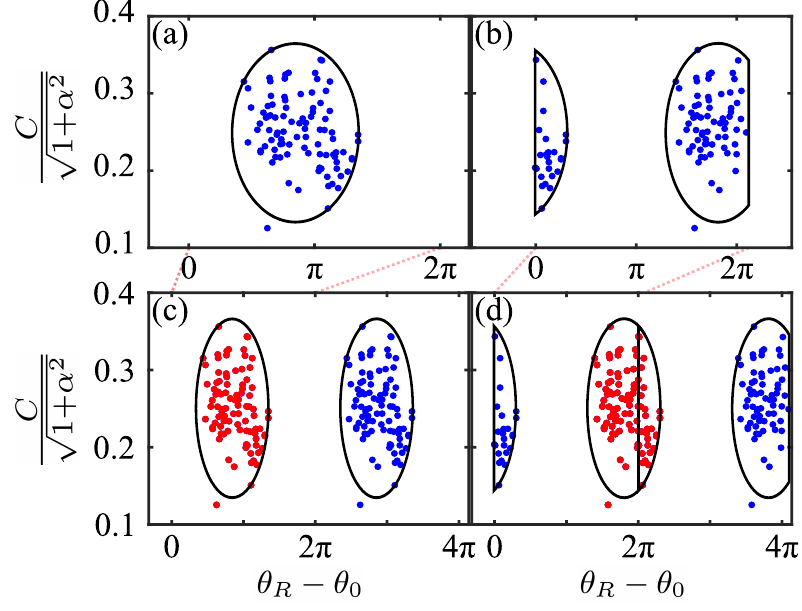
√ (cid:104) (cid:105) C / ( 1 + α 2 ) , θ R − θ 0 pairs for SX2. ( a ) the point cloud